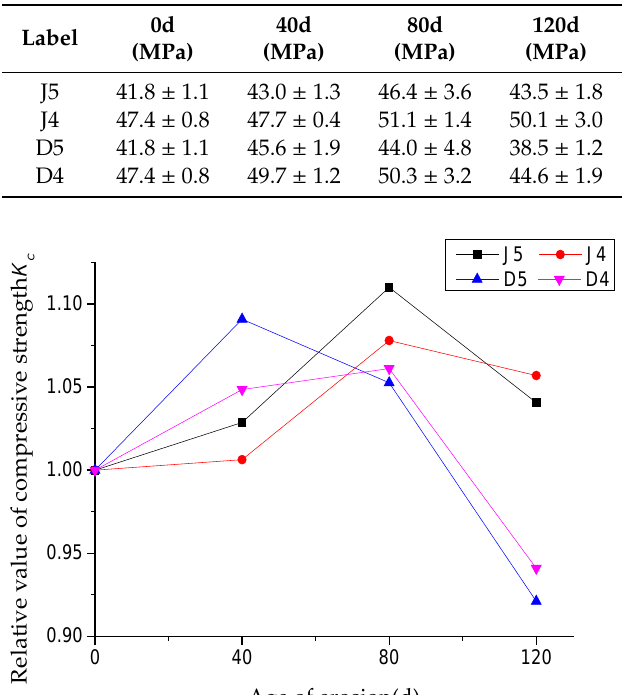
Table 7. Compressive strength of concrete under different erosion ages.